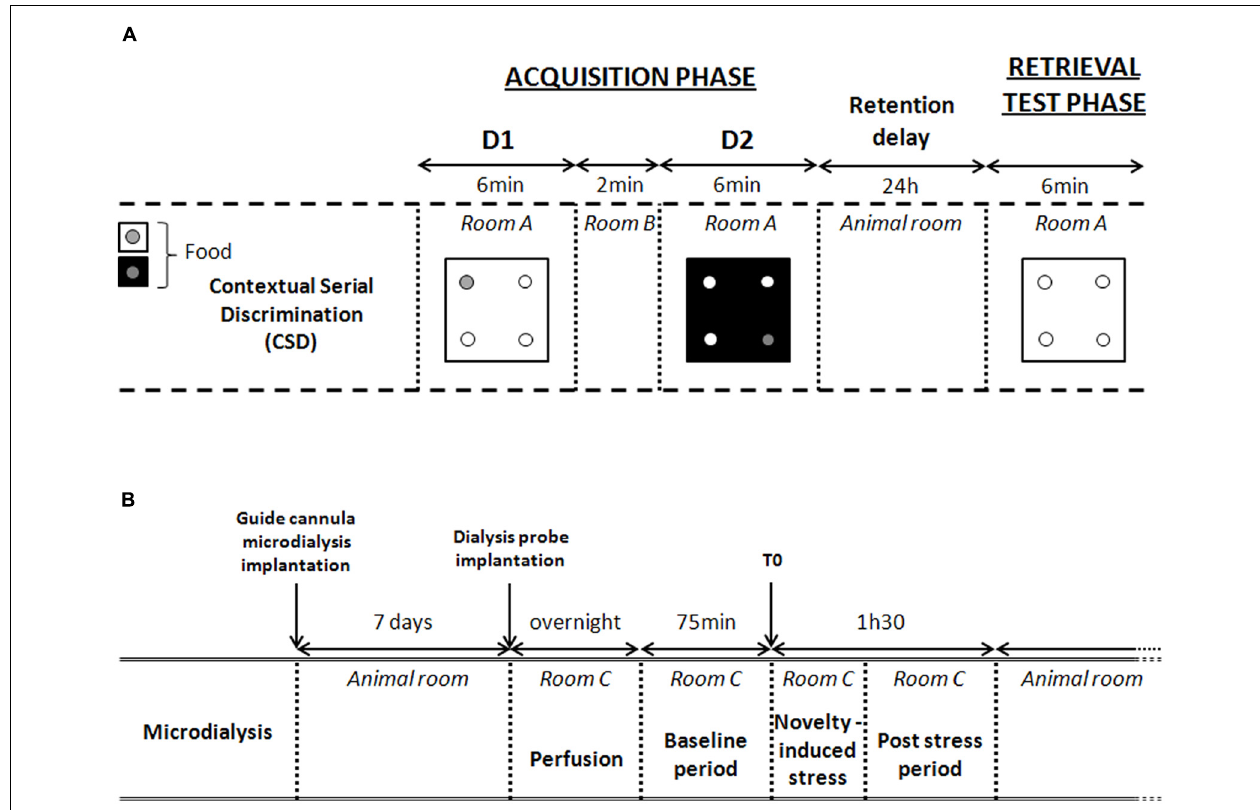
FIGURE 2 | Experimental procedures. (A) Experimental procedure of the contextual serial discrimination (CSD) behavioral task. D1, discrimination 1; D2, discrimination 2. During retrieval test phase, each mouse is evaluated on D1 floor without food reward. (B) Detailed description of microdialysis procedure. Time 0 (T0) corresponds to the last point of